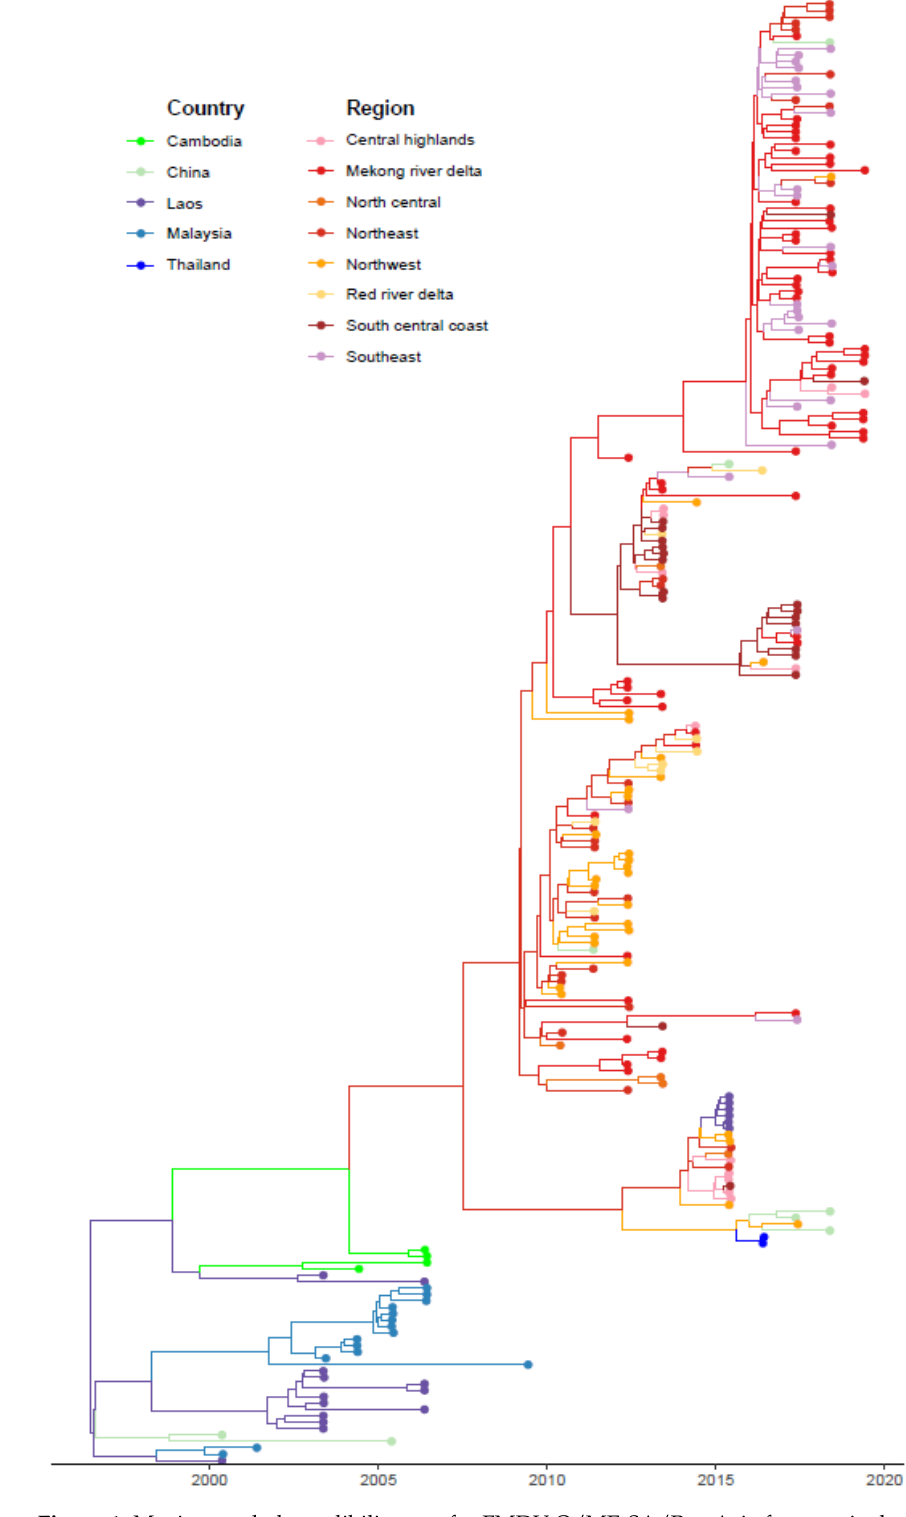
Figure 1. Maximum clade credibility tree for FMDV O/ME-SA/Pan Asia from agricultural zones of Vietnam and surrounding countries of China, Laos, Malaysia, Thailand. Nodes and branches of the tree are colored by location.